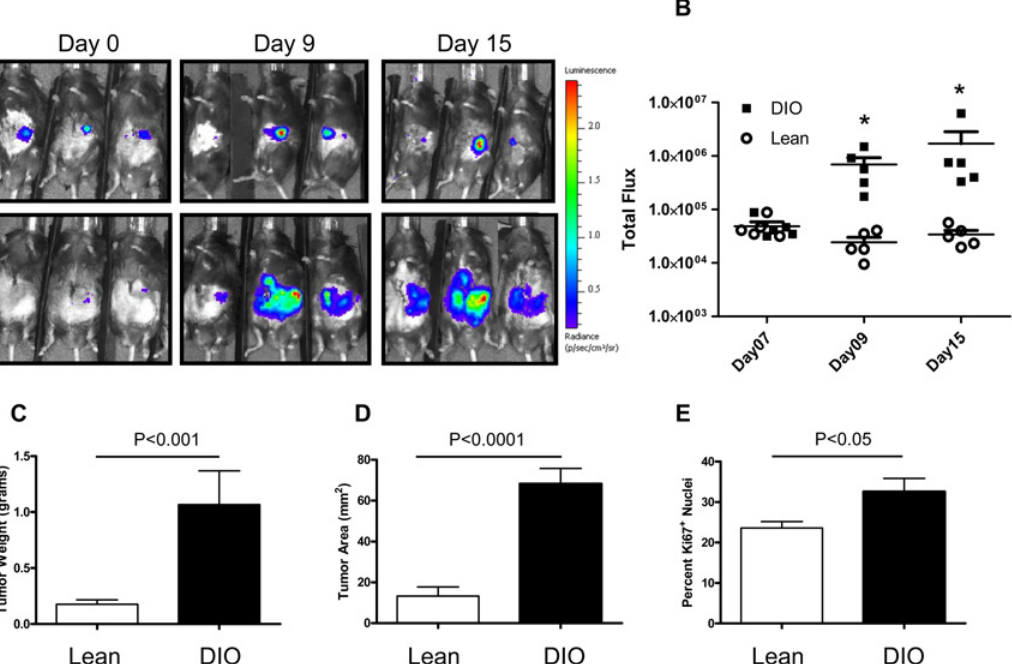
Fig 2. Diet induced obesity increases orthotopic Panc02 pancreatic tumor growth. Bioluminescence revealed increased growth over time in DIO mice compared to lean mice (A). Total flux from luciferase imaging was statistically different by Day09 after orthotopic tumor cell injection (B). Endpoint tumor weight (C) as well as tumor area (D) were significantly increased in the DIO mice. Proliferation assessed by Ki67 staining was increased in DIO tumors compared to lean tumors (E). Radiance heat map scale is x10 5 p/sec/cm 2 /sr. Statistical analysis by Mann-Whitney of p < 0.0079 ( *